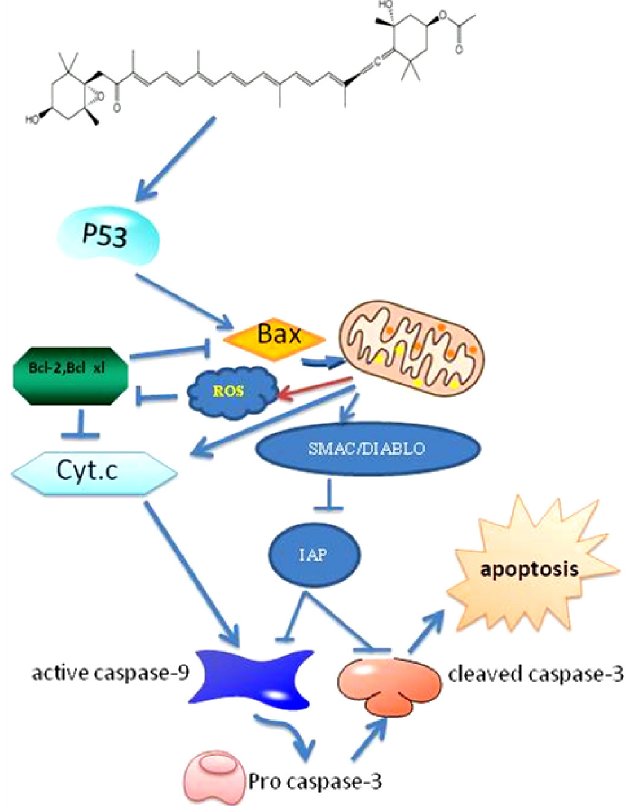
Figure 2. Fucoxanthin and the apoptosis signaling